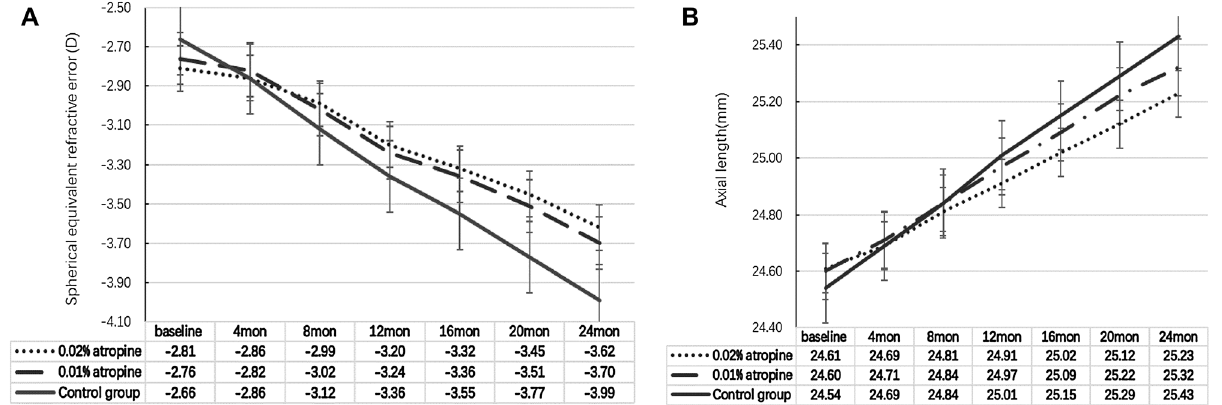
Figure 2. Measurement of spherical equivalent refractive error and axial length over